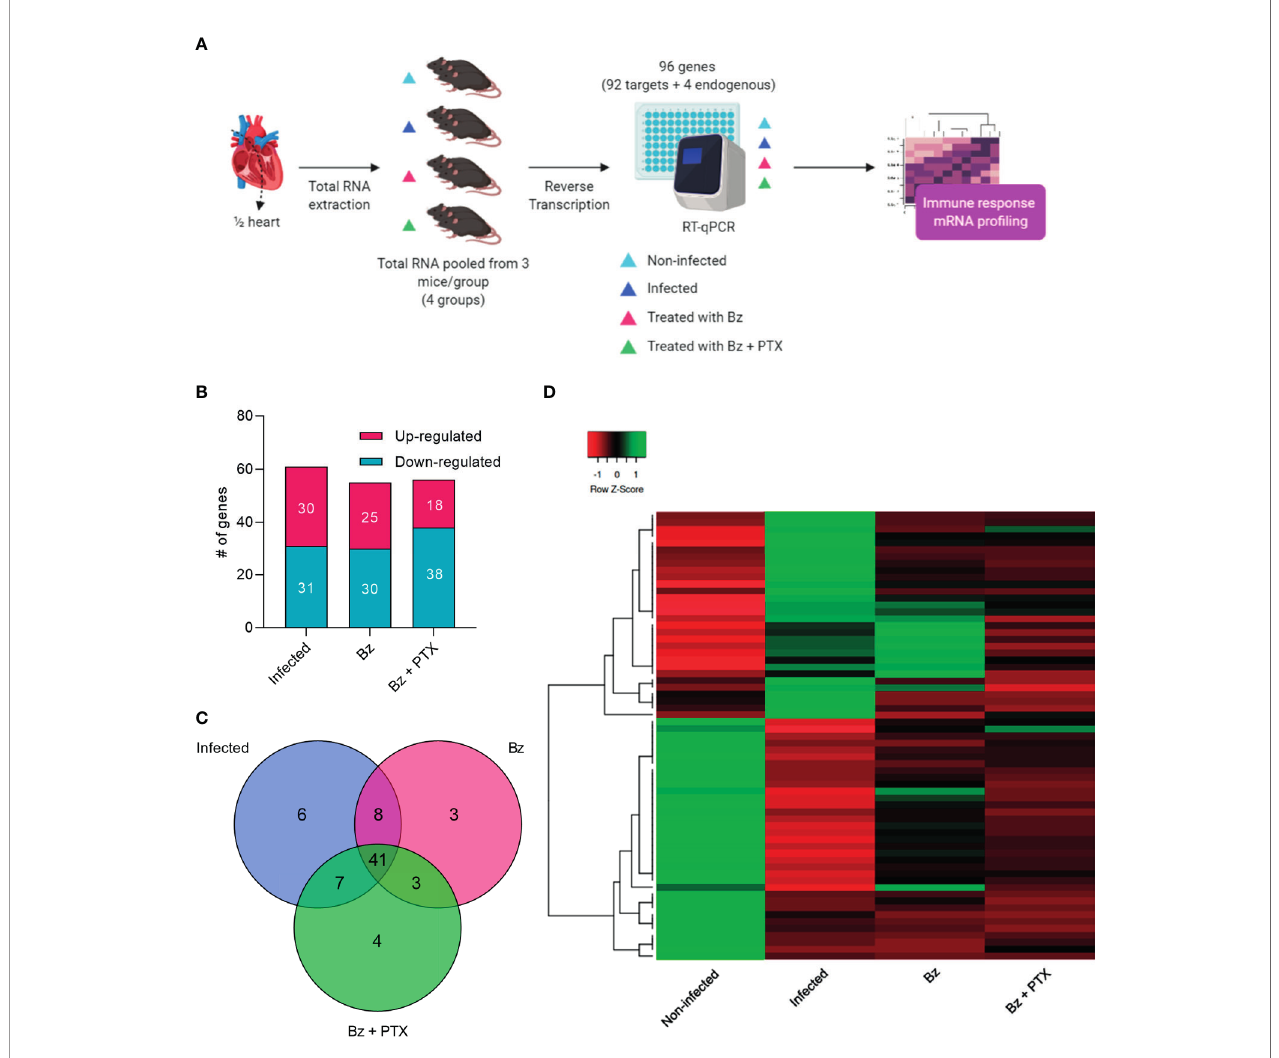
FIGURE 2 | Overview and characterization of immune array analysis. (A) Schematic design of array work fl ow. Mice cardiac tissues were harvested 30 days after therapy and ½ of the heart was submitted to total RNA extraction, subsequent reverse transcription, and RT-qPCR of 92 immune-related genes (92 targets + 4 endogenous controls). (B) Number of altered genes in each group. (C) Venn diagram showing the number of altered expressed genes in each group. (D) Heatmap and hierarchical clustering. The color scale illustrates gene ’ s fold change after global normalization; red represents − 1 to 0 and green is 0 to 1. Clustering was performed using average linkage distance measurement method: Spearman Rank correlation. #: